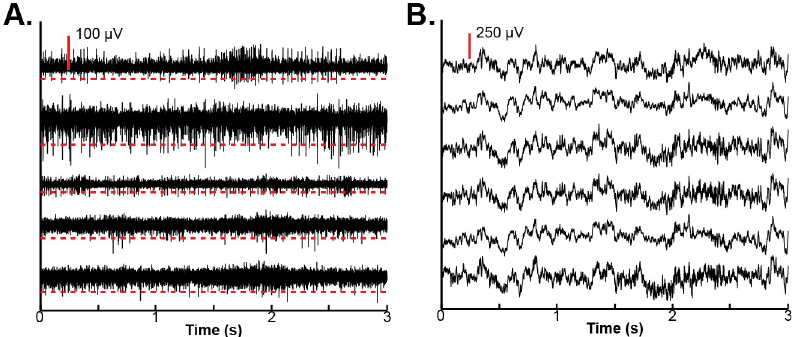
Fig 3. Electrophysiological analyses. Multi-unit firing and local-field potential (LFP) activity were examined in each recording session. A. To examine multi-unit firing, signals were re-referenced to the common average and band-pass filtered between 300Hz and 3000Hz. Each trace shows data filtered for multi-unit activity and aligned to the same time point from randomly selected channels in a single rat. A scale of 100 μ V is indicated by the vertical red line. The multi- unit detection threshold of -4.5 x the RMS voltage of each channel is shown by the dashed red line below each trace. B. LFP activity was visualized by filtering between 5Hz and 400Hz after re-referencing to the common average. Each trace shows data filtered for LFP activity and aligned to the same time point from randomly selected channels in a single rat. A scale of 250 μ V is indicated by the vertical red